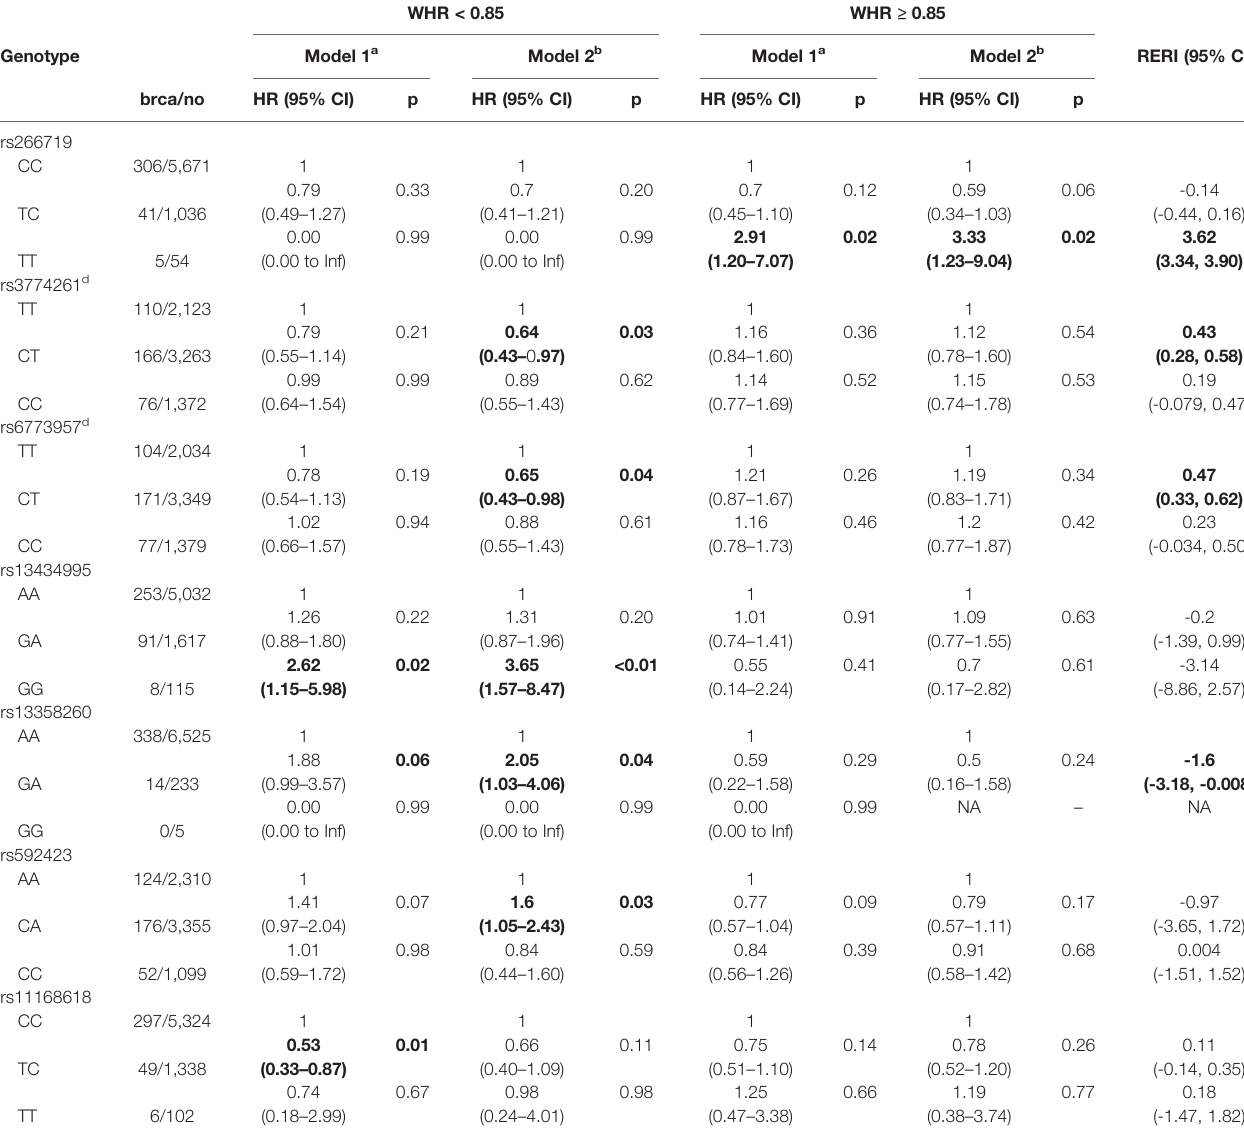
TABLE 5 | Association between adiponectin-related SNPs and postmenopausal invasive breast cancer risk, by WC status.